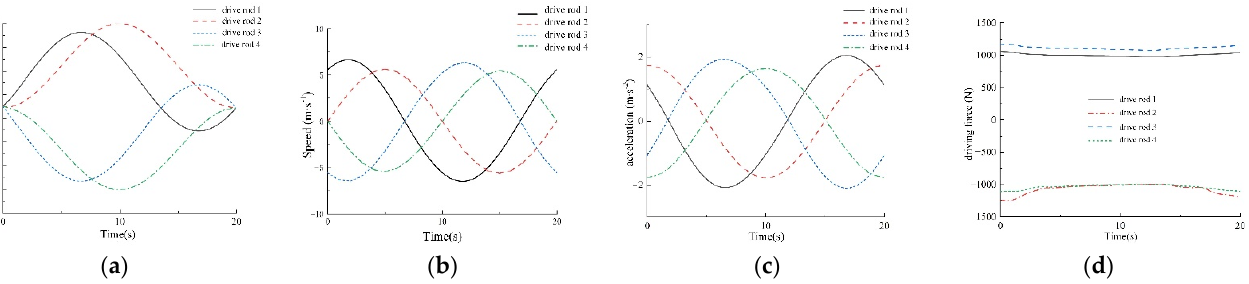
Figure 5. Simulation curve ( a ) of rod length variation; ( b ) of velocity change; ( c ) of acceleration change; ( d ) of driving force change.